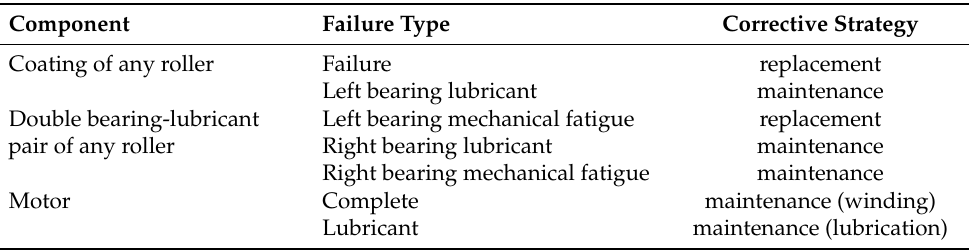
Table 20. Optimal corrective strategies for the model with paired coated rollers for the bleaching machine (ZORLUTEKS).